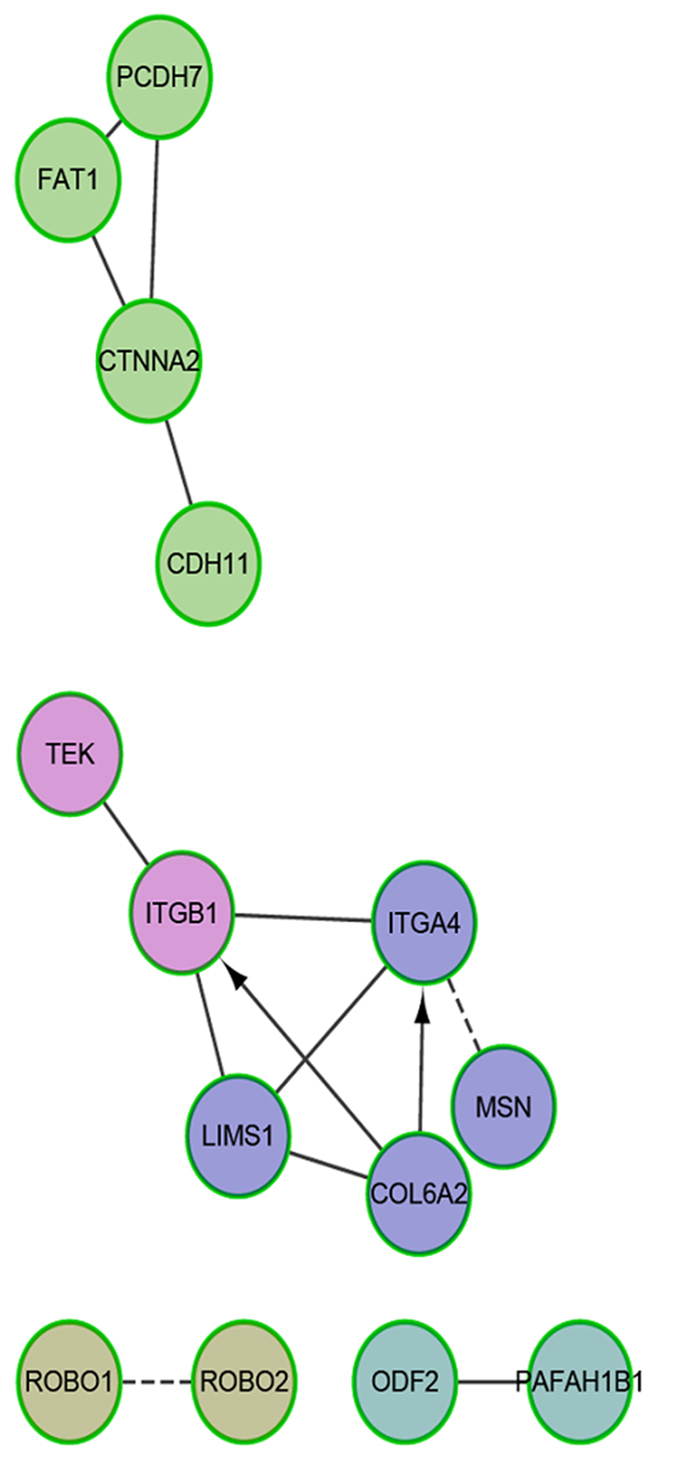
Concise functional interaction network of selected TDETGs.The effect of the interaction is represented by arrows, straight line and imaginary line. “− >” for activating/catalyzing, “−” for FIs extracted from complexes or inputs, and “−” for predicted FIs.